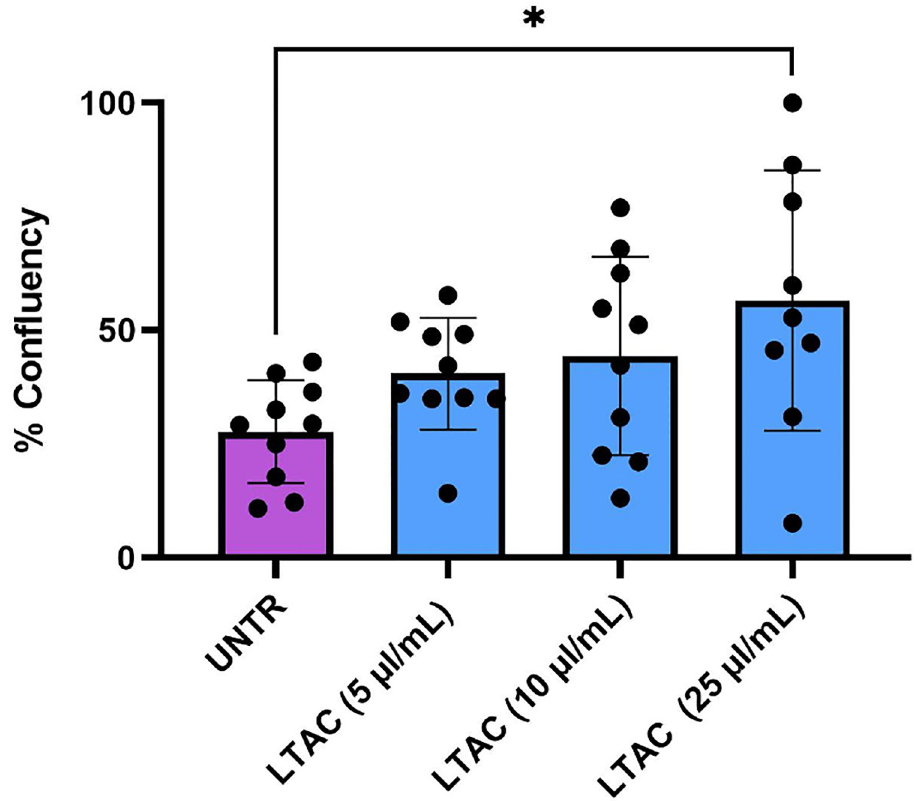
Fig 3. Suppression of FHV-1 induced cytopathic effects by pre-treatment with LTAC nanoparticles. Feline Fcwf-4 macrophages in triplicate wells were treated with 3 different concentrations of LTAC nanoparticles for 6 hours, after which the nanoparticles were removed and the cells infected with FHV-1 for 2 hours as described in Methods. Cell confluency as a measure of cytopathic effects was assessed by Incucyte at 48 hours for untreated, uninfected cells, FHV-1 infected and untreated cells, and for FHV-1 infected and LTAC-treated cells. Statistical evaluation of study data was done using ANOVA, and Tukey-Kramer post-test, with significance set at p < 0.05. Similar results were obtained in two additional, independent experiments.